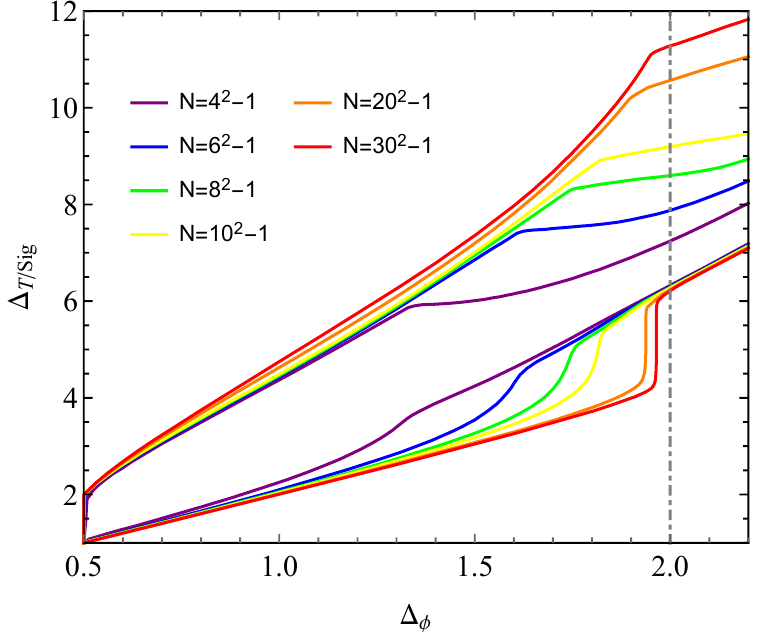
Figure 3 . Bounds on ∆ Sig (upper set) and ∆ T (lower set) from SO( N ) vector